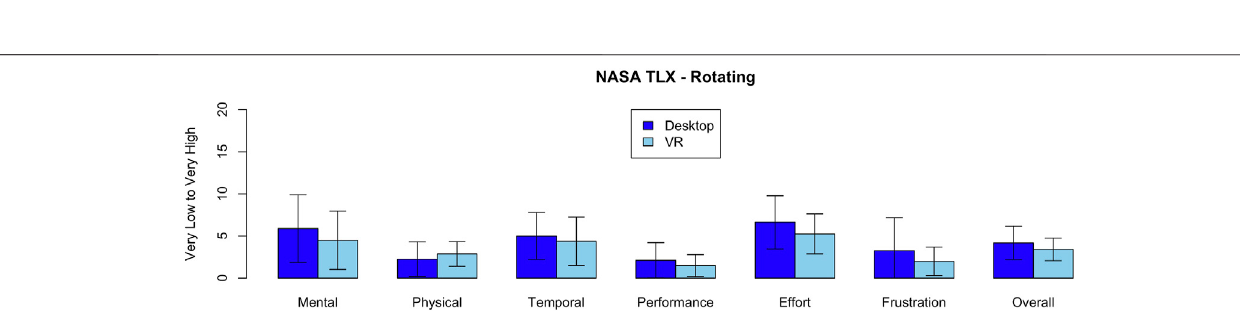
Frontiers in Virtual Reality |